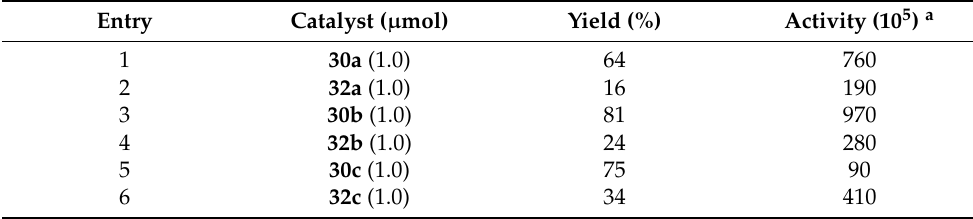
Table 4. Comparison of the catalytic performances of the unsymmetrical PNN and PNP nickel pincer complexes 30a – 30c and 32a – 32c for the catalytic polymerization of norbornene.